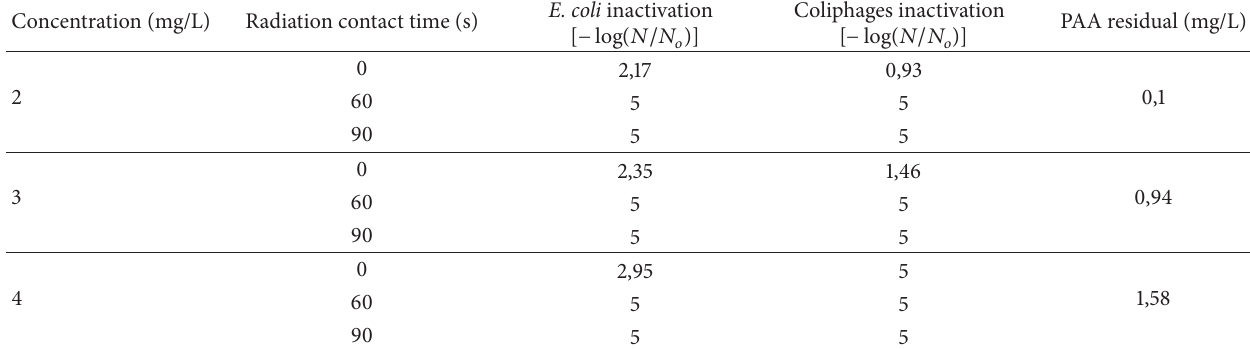
Table 6: E. coli and coliphages inactivation with the sequential PAA/UV method with synthetic water. Concentration (mg/L) Radiation contact time